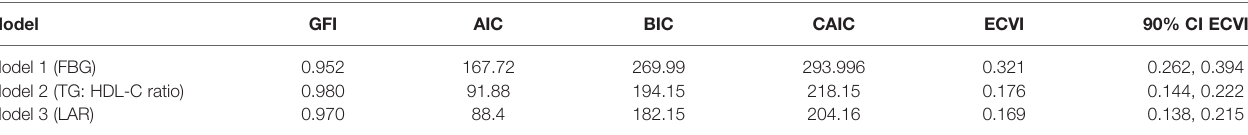
FBG, fasting blood glucose; LAR, leptin:adiponectin ratio; GFI, goodness of fi t; AIC, Akaike ’ s inclusion criterion; BIC, Bayesian information criterion; CAIC, consistent AIC; ECVI, Expected Cross-Validation Index. Parsimonious model is indicated by relatively higher GFI and relatively smaller AIC, CAIC, and ECVI. Model 2 shows comparable fi tness with the reference model (model